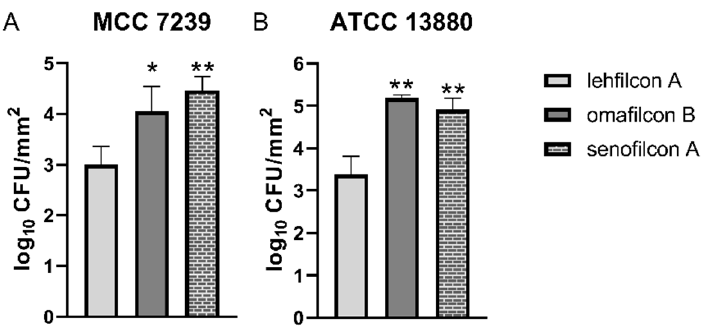
Figure 6. The phenomenon of low adhesion to lehfilcon A generalizes across S. marcescens strains. Adhesion assay using ( A ) S. marcescens strain MCC 7239 or ( B ) strain ATCC 13880 exposed to soft contact lenses ( n = 6 per lens material) in TSB medium containing 10% FBS as a soiling agent. Graphs depict the average log density of cells recovered after adhesion reactions (log CFU/mm 2 +/ − S.D.). * indicates p < 0.001 and ** indicates p < 0.0001 for comparisons to lehfilcon A.